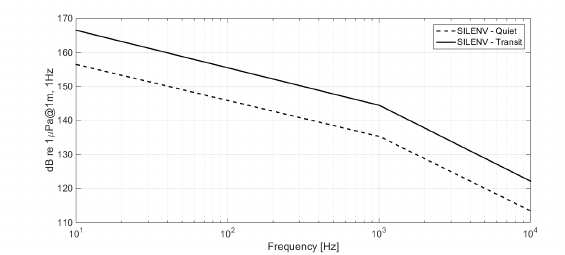
Figure 6: SILENV limits for the underwater noise radiated from com- mercial ships